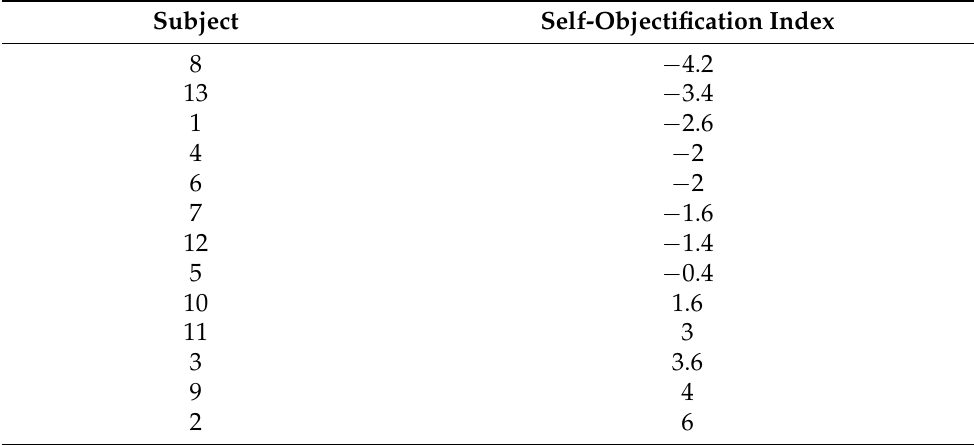
Table 1. Self-objectification index (SOI) of